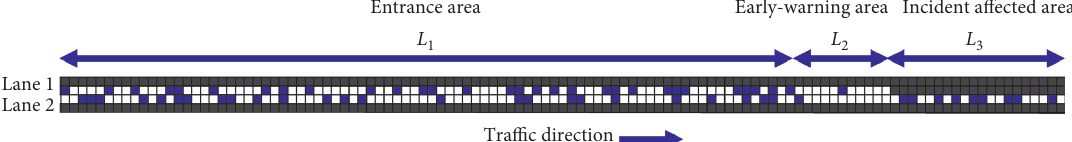
Figure 1: Schematic of the manual driving